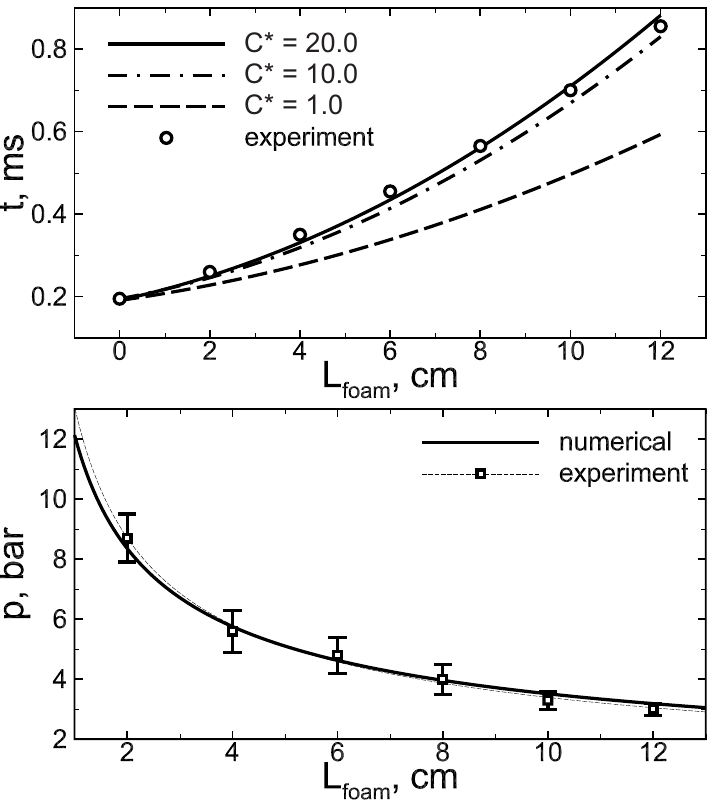
Figure 1. Comparison between the numerical and experimental data [29] on the blast wave atten- uation by the foam layers of different thicknesses. Time of blast wave arrival ( top ) and pressure registered behind the wave ( bottom ) are